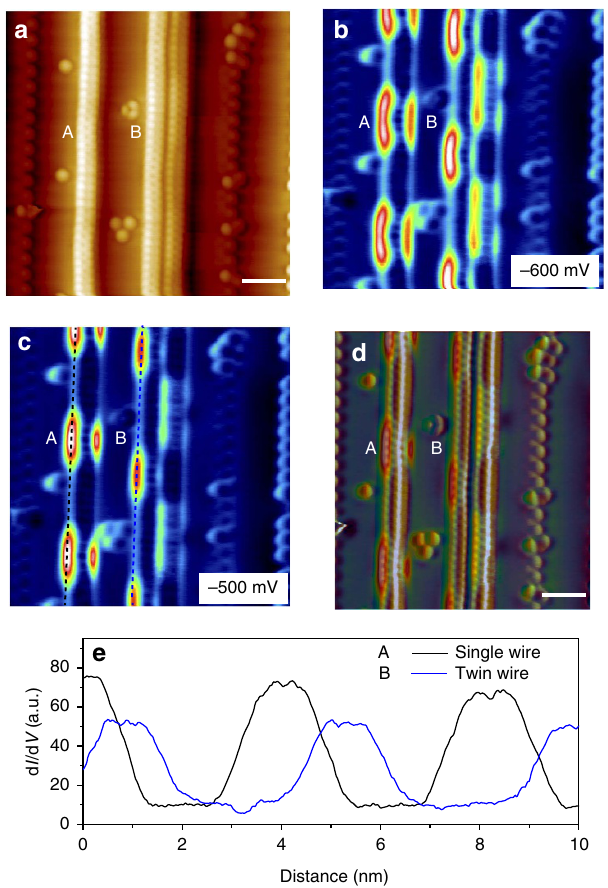
Figure 5 | Periodic electronic patterns on the MoS 2 nanowires. ( a ) Topography image of MoS 2 nanowires obtained by high-resolution NC-AFM ( f 0 ¼ 23.1kHz, df ¼ (cid:3) 16Hz, T ¼ 4.5K). What is shown here includes a single nanowire (A) and a twin nanowire (B). The dark line between the twin nanowires suggests that the individual wire has not fused and there is coulombic repulsion between the two wires. ( b , c ) Typical d I /d V maps (10 (cid:4) 10nm 2 ) recorded in at various bias voltage with same tip with a in STM mode. ( d ) d I /d V map ( V b ¼ (cid:3) 600mV) overlaid onto the NC-AFM topographic image. ( e ) Line profile along the MoS 2 wires in c denoted by black (blue) dotted lines, demonstrating the same periodic oscillation of tunnelling conductance along them. Scale bars, 1nm ( a , d